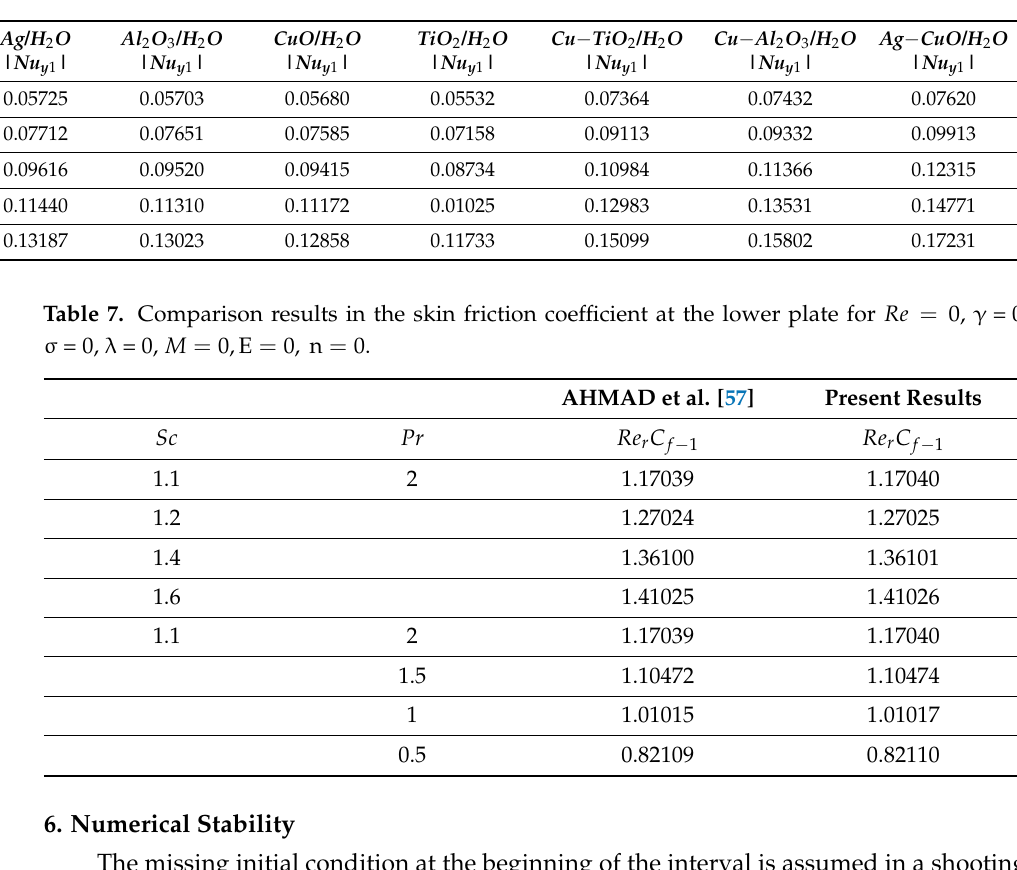
Table 6. Impact on the Nusselt number in volume fraction for nanofluids and trihybrid nanofluids.